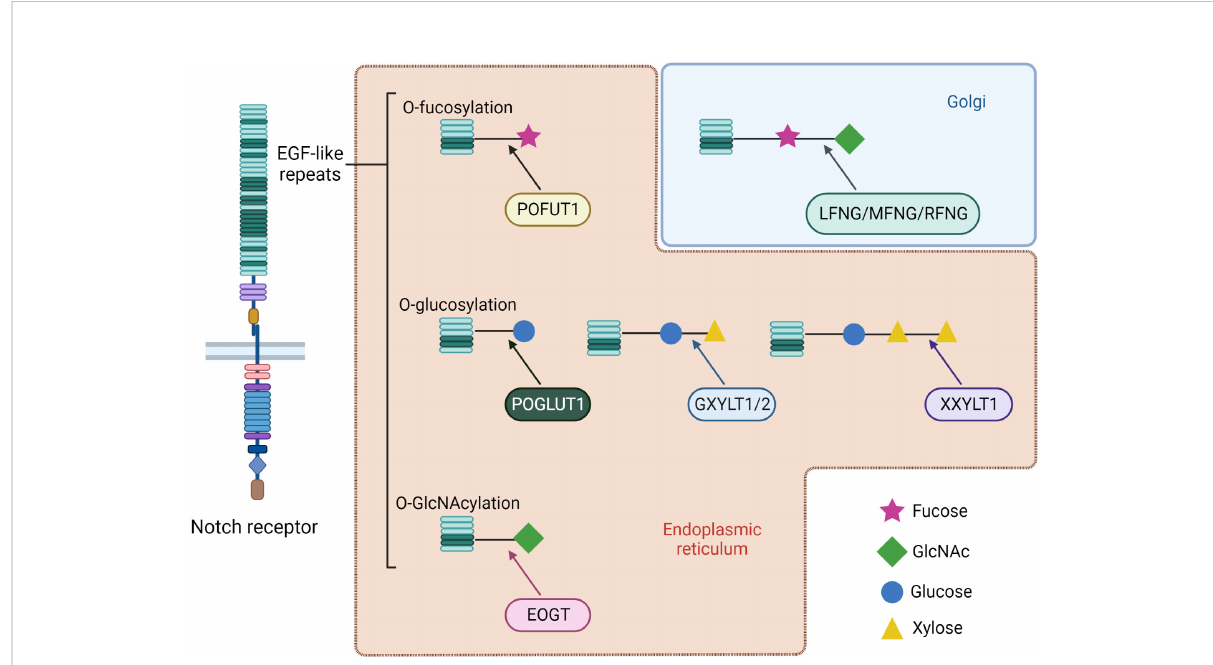
FIGURE 3 Types of receptors O-glycosylation and further post-translational modi fi cation of speci fi c EGF-like repeats of Notch receptors. Most of the changes occur by ER enzymes during receptor maturation. An exception is represented by elongation of O-linked fucose with the addition of N-acetylglucosamine by the Fringe family glycosyltransferases, which are localized in the Golgi apparatus. Mammals have three homologs of Drosophila Fringe: Lunatic, Manic and Radical Fringe (LFNG, MFNG and RFNG). Depending on the physiological context, a modi fi cation can enhance receptor interaction with a speci fi c family of ligands. At the same time, enzymes responsible for these modi fi cations often have chaperon activity on Notch, hence representing fundamental proteins for correct traf fi cking and